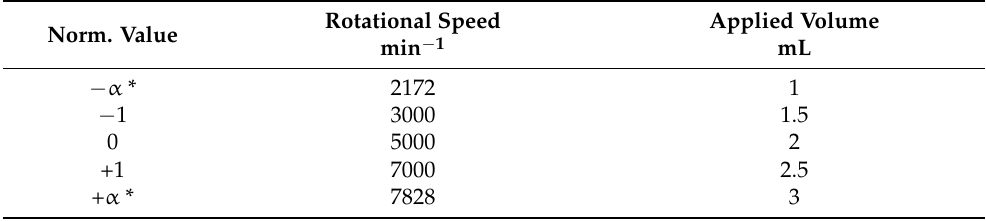
Table 3. Parameters for parametric study for spin coating on PP carriers. Norm. Value